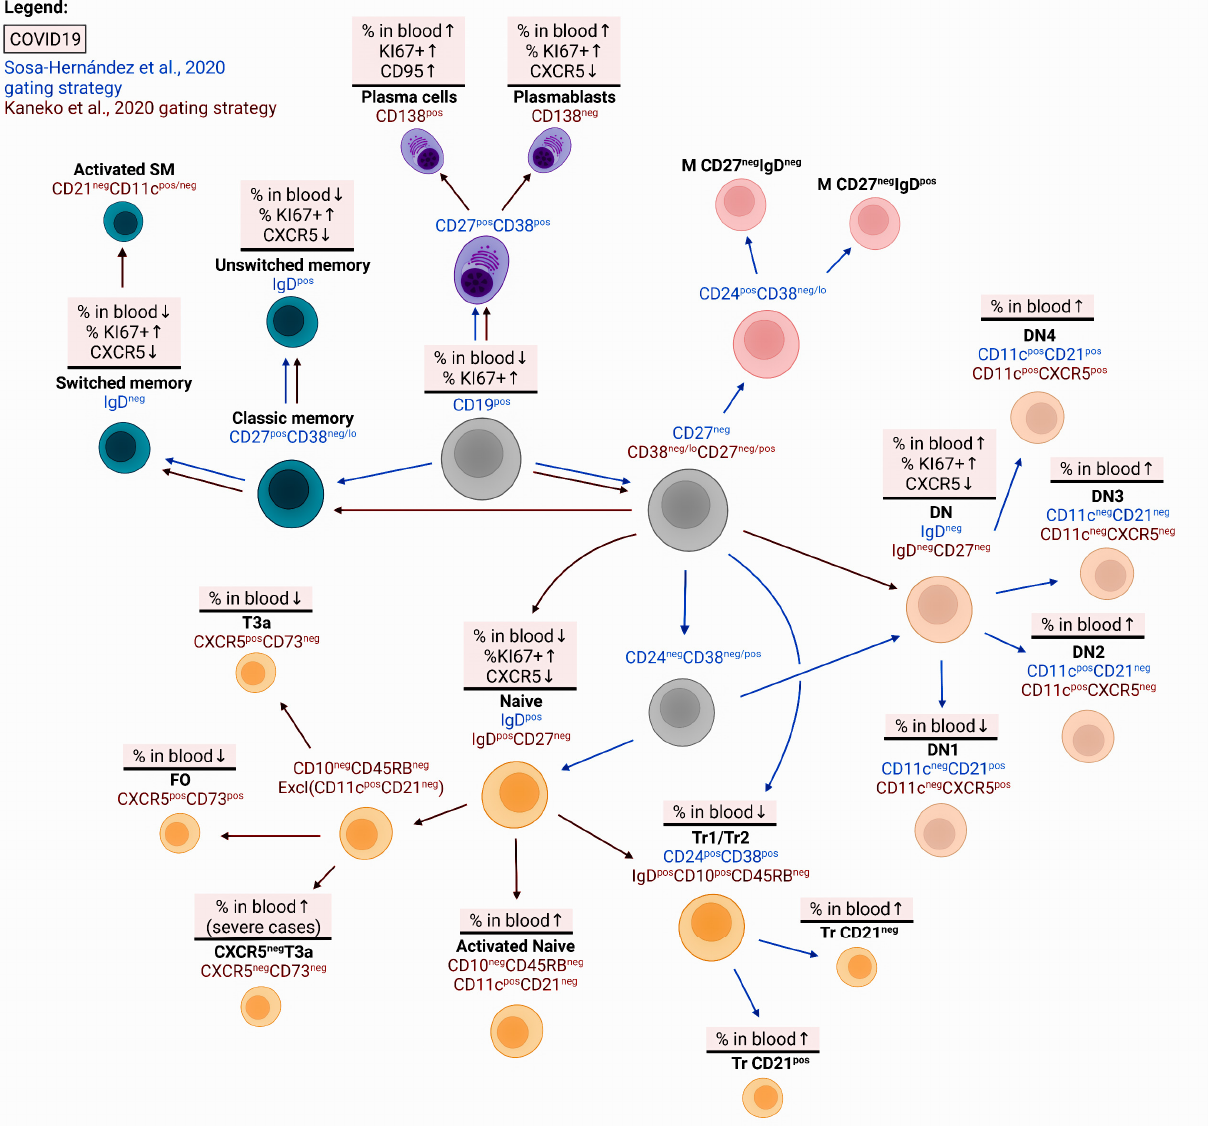
Figure 3. Abnormalities of B cell development and maturation in SARS-CoV-2-infected patient. Lower relative and absolute numbers of circulating main B cell subsets were found in patients with COVID-19 if compared to control, but these patients exhibited elevated levels of circulating CD20–CD38highCD27high plasmablasts and CD21-negative B lymphocytes pointing to impaired maturation and differentiation of memory and effector B cells in peripheral lymphoid tissue.